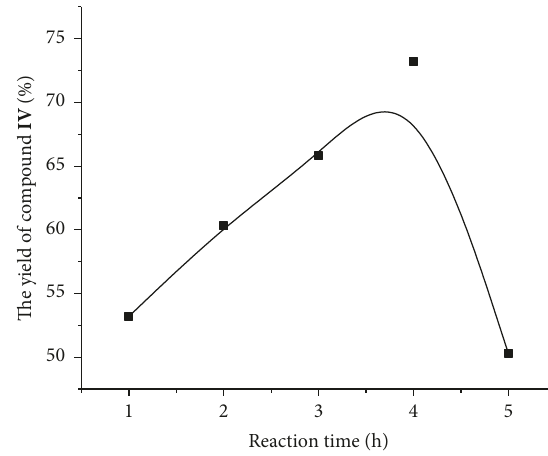
Figure 8: Impact of mole ratio of acetyl chloride.